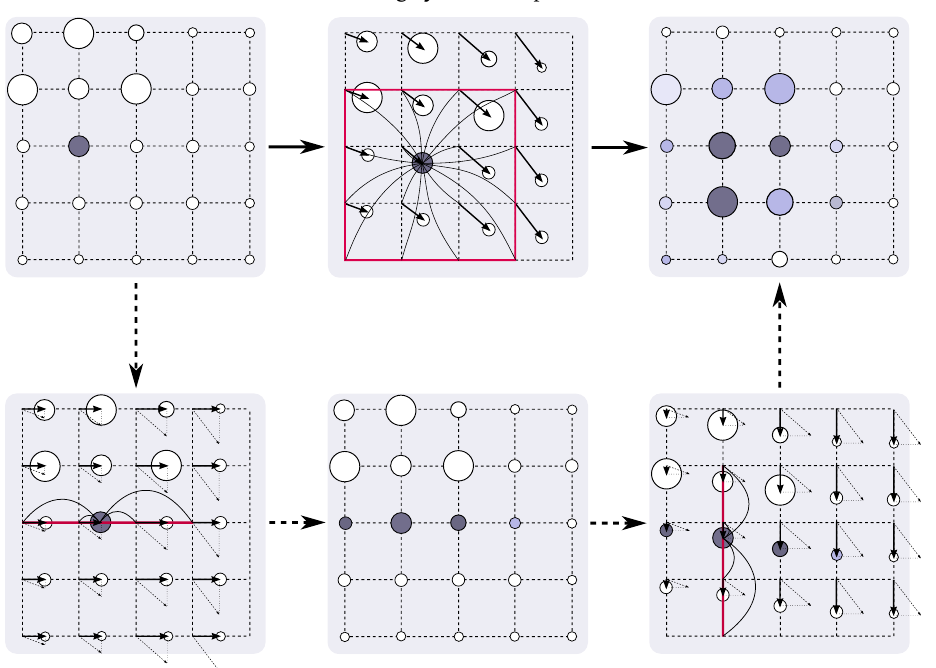
Figure 3. Remeshing steps using a tensorial product (on top, depicted by plain arrows) and a directional splitting [82] (on bottom, depicted by dashed arrows). The red lines indicate the support of the remeshing kernel. In this example, the kernel has a 1D-support of 4